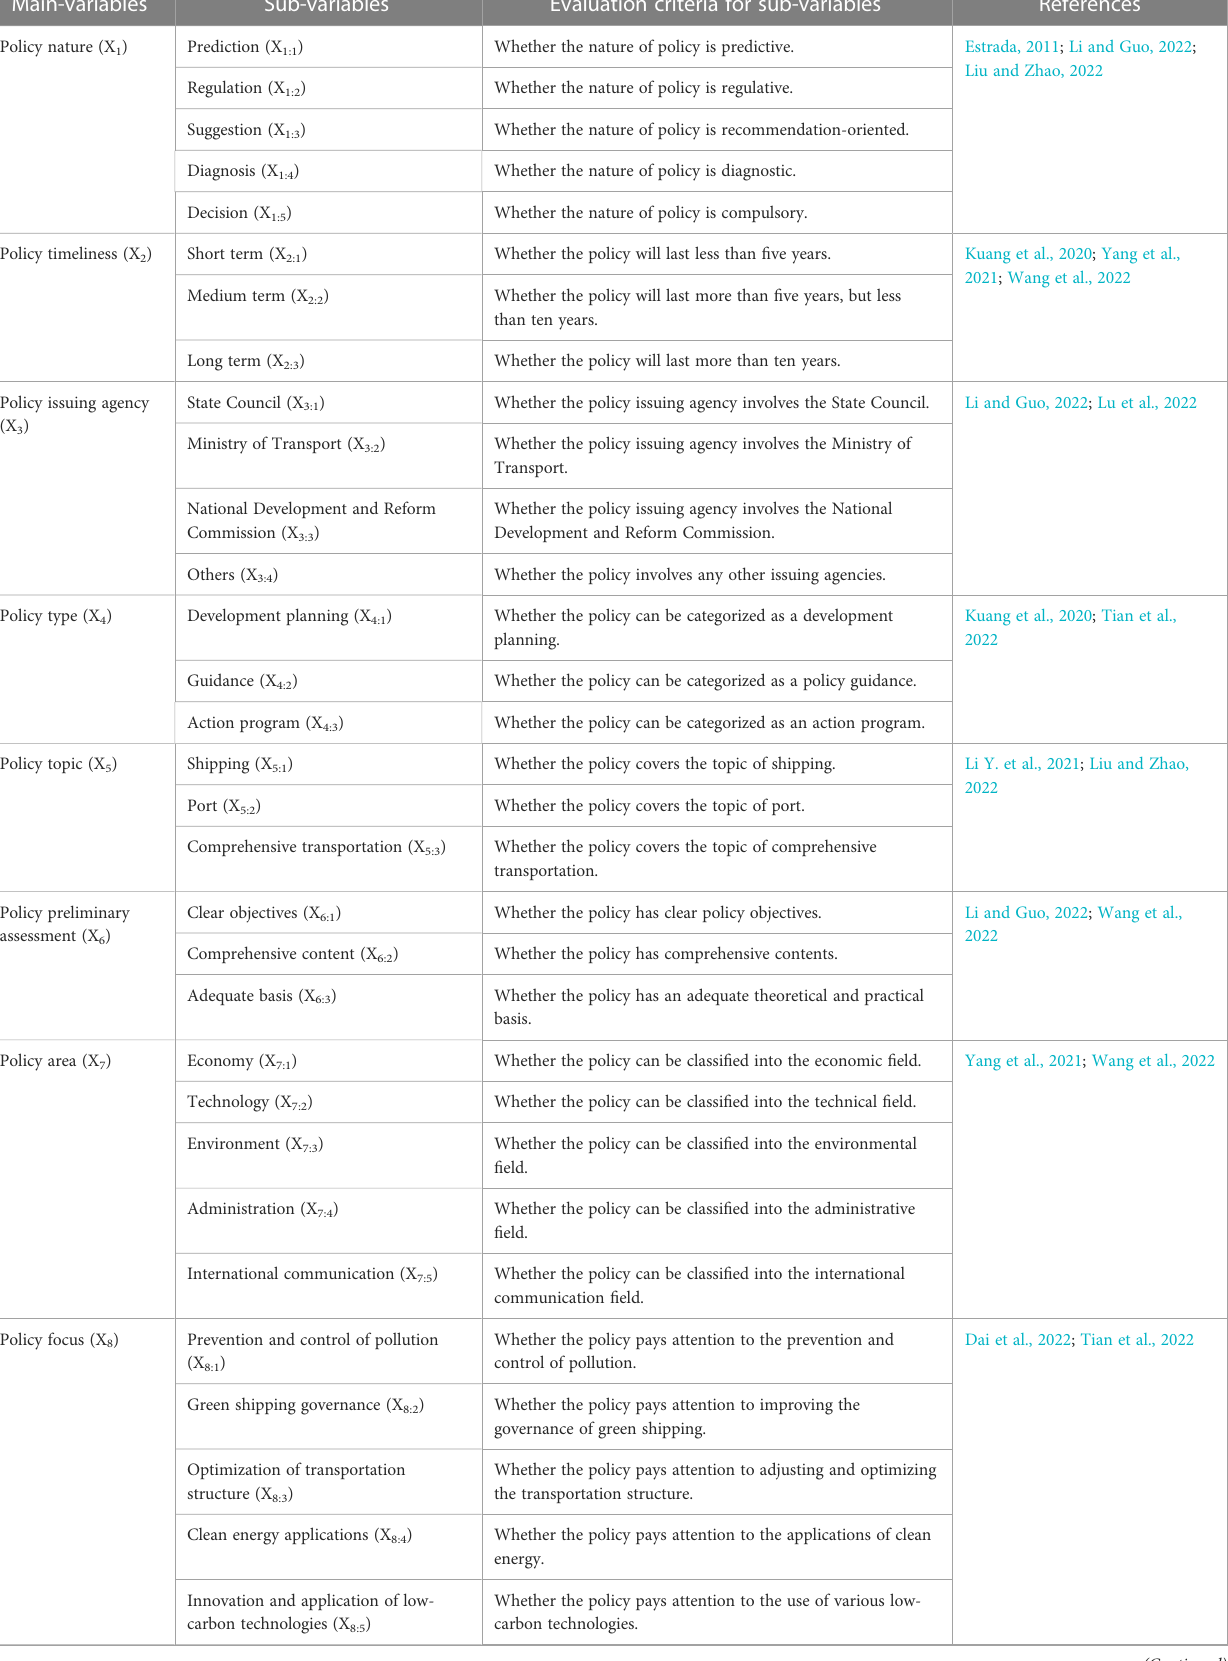
TABLE 2 Variables setting for evaluation of China ’ s shipping decarbonization